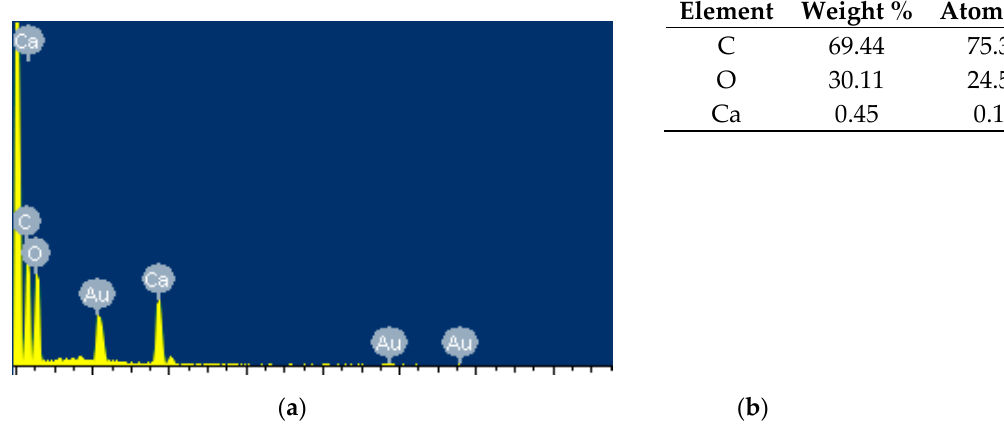
Figure 5. ( a ) EDS Image of nodules observed over the crushed sample surface, ( b ) quantity of elements spread on the deposited nodules in the surface showed in Figure 4e.